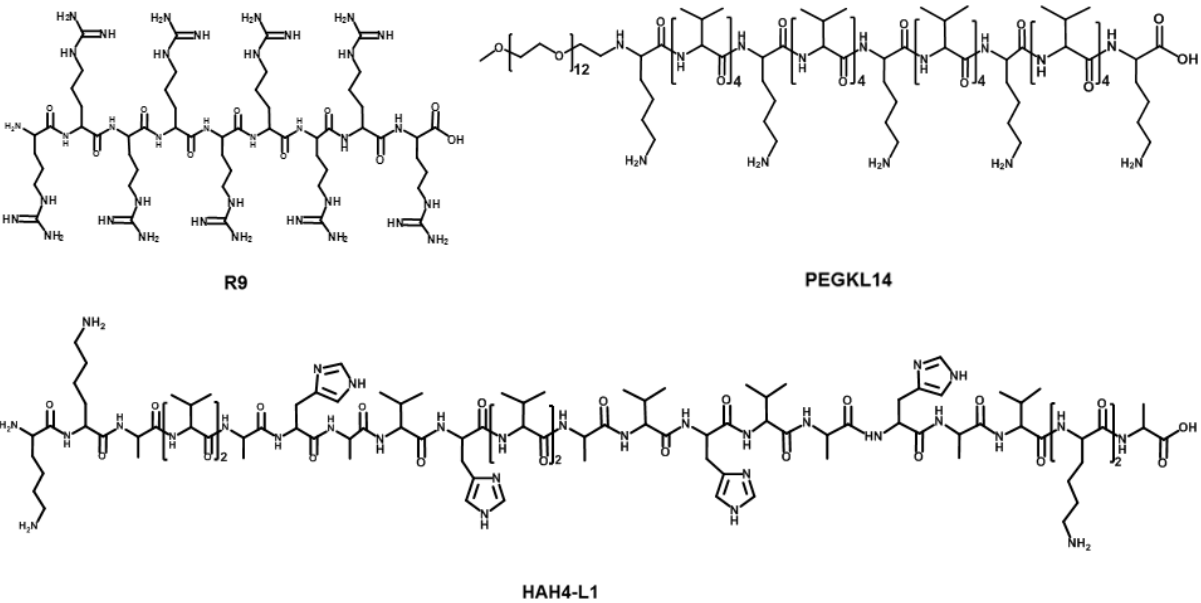
Figure 3. Representative cationic peptides for mRNA delivery